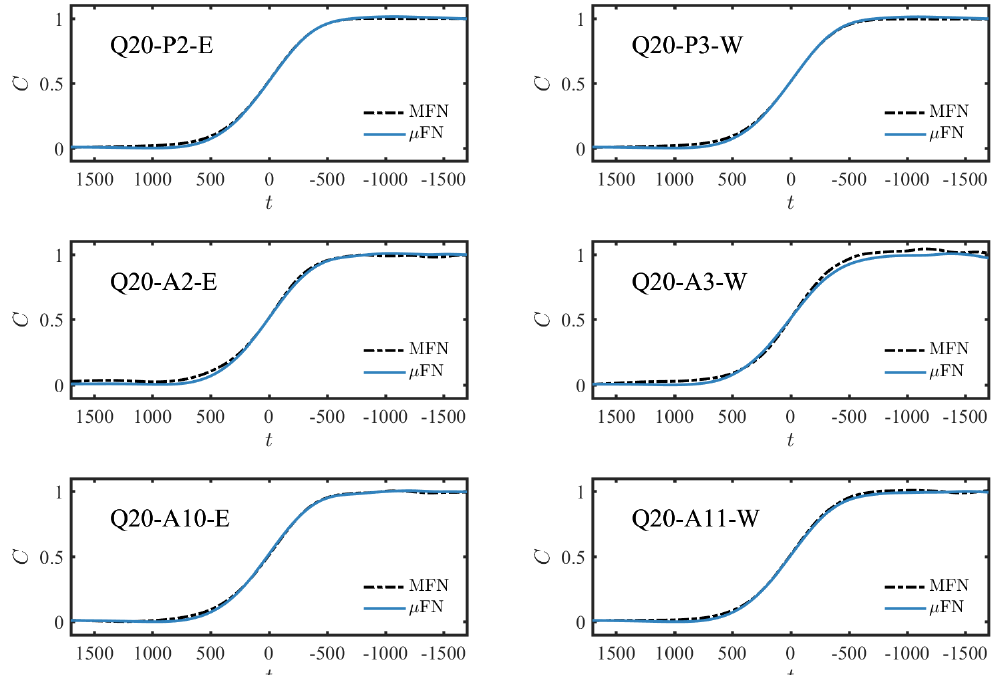
Figure A6. Measured breakthrough curves in the MFN (dashed line) and µ FN (solid line) at upstream (east) and downstream (west) locations on the same primary (P2–P3), secondary (A10–A11) and tertiary (A2–A3) fracture at Q = 20 µ L/h.